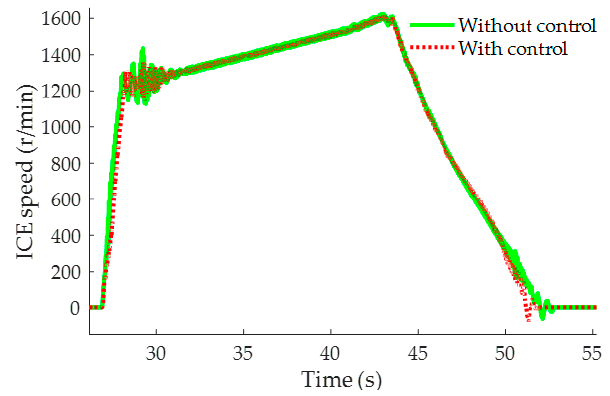
Figure 19. Engine speed.